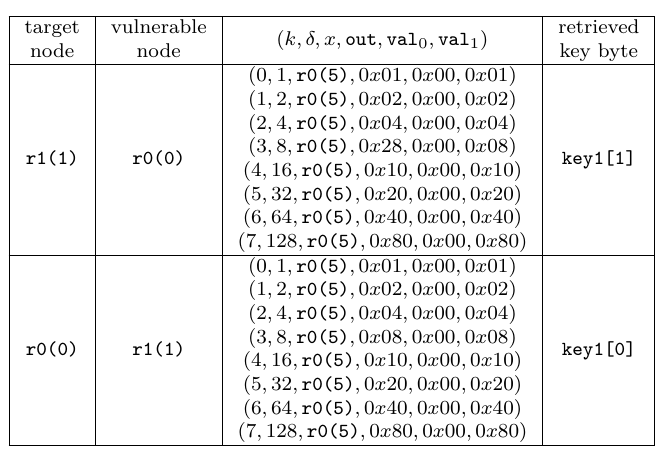
Table 8: Summary of TADA output for DFA attacks on F ex in Table 2 (values of x, out , var 0 , var 1 are in hexadecimal